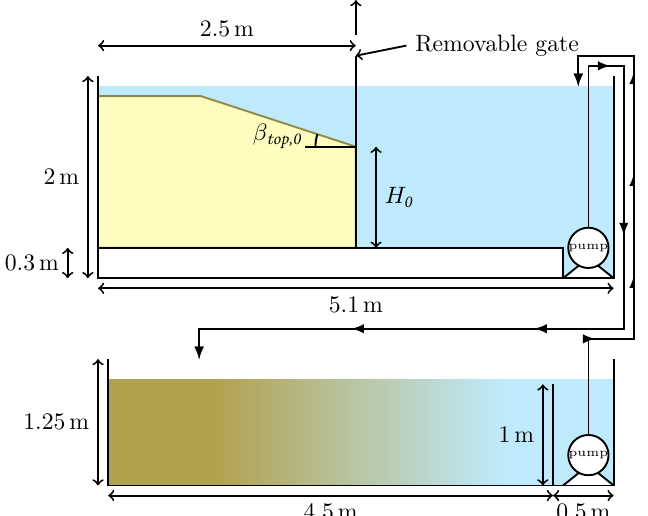
Figure 5. Front view of the experimental setup illustrating all components: breaching tank ( Top ) and sedimentation tank ( Bottom ).